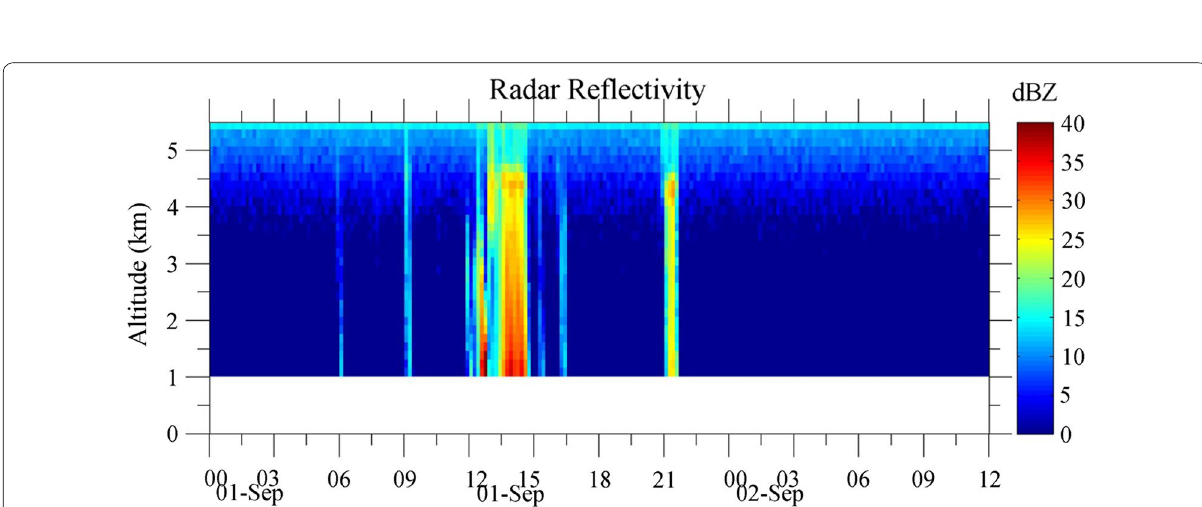
Fig. 21 Radar reflectivity observed with MRR at the EAR site from 00:00 LT on September 1 to 12:00 LT on September 2, 2016. Averaging time is 10